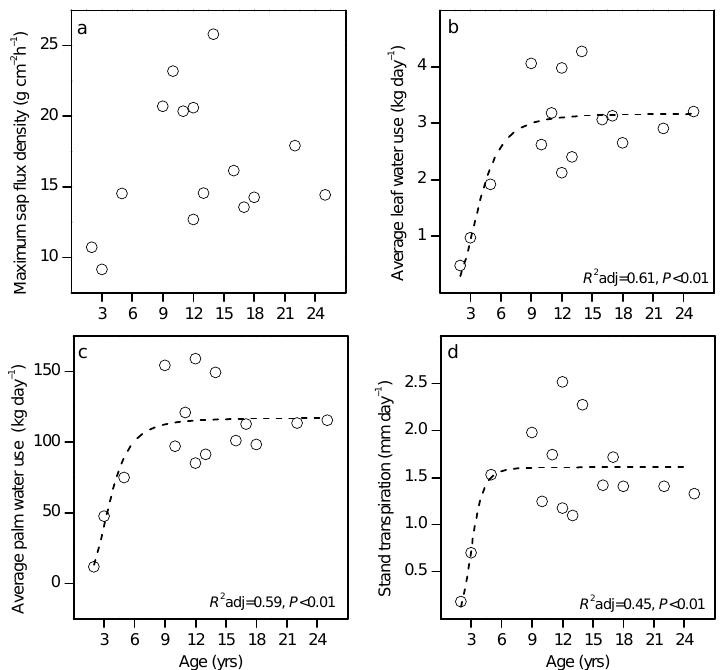
Figure A1. The change of maximum hourly sap flux density (a) , average leaf water use (b) , average palm water use (c) and stand transpiration (d) over stand age. Data of the different levels derived from simultaneous sap flux measurements on at least 13 leaves per stand; values of three sunny days averaged. The provided fits are Hill functions (dotted